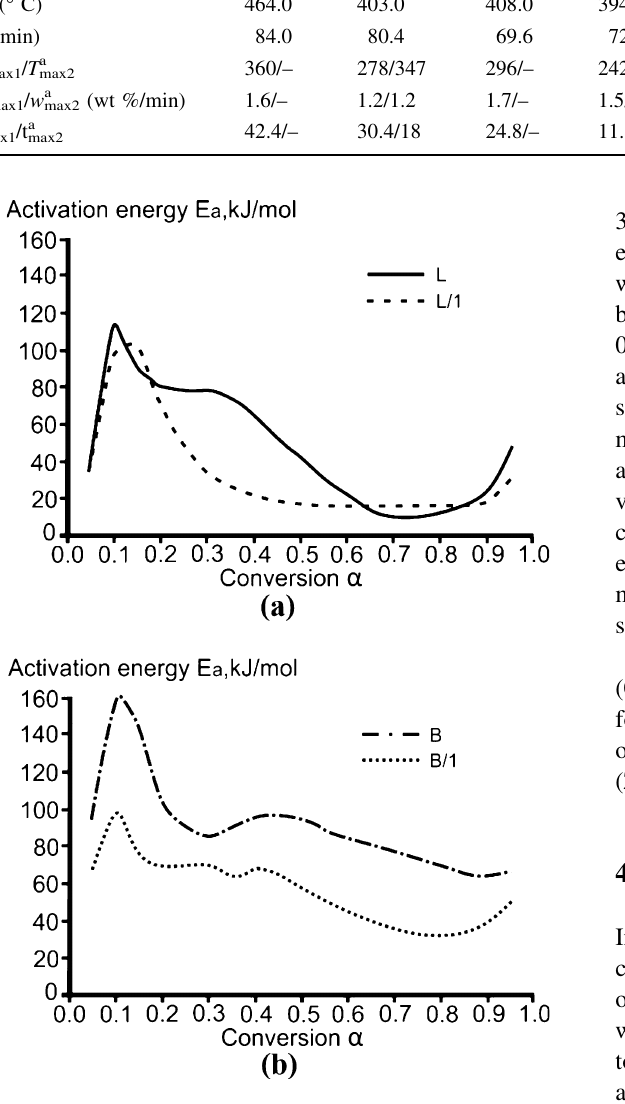
Fig. 9 Dependence of the activation energy on the conversion of lignite a and bituminous coal b samples for the initial and copper nitrate modified samples. The activation energy values were defined at heating rates of 2.5, 10, 25, and 40 (cid:3)